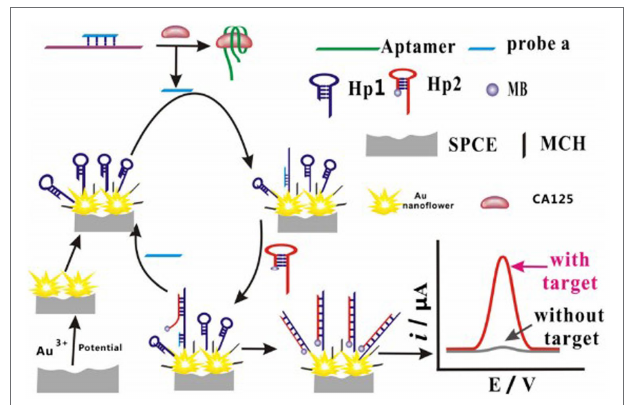
FIGURE 1 | Diagram depicting the strand displacement amplification